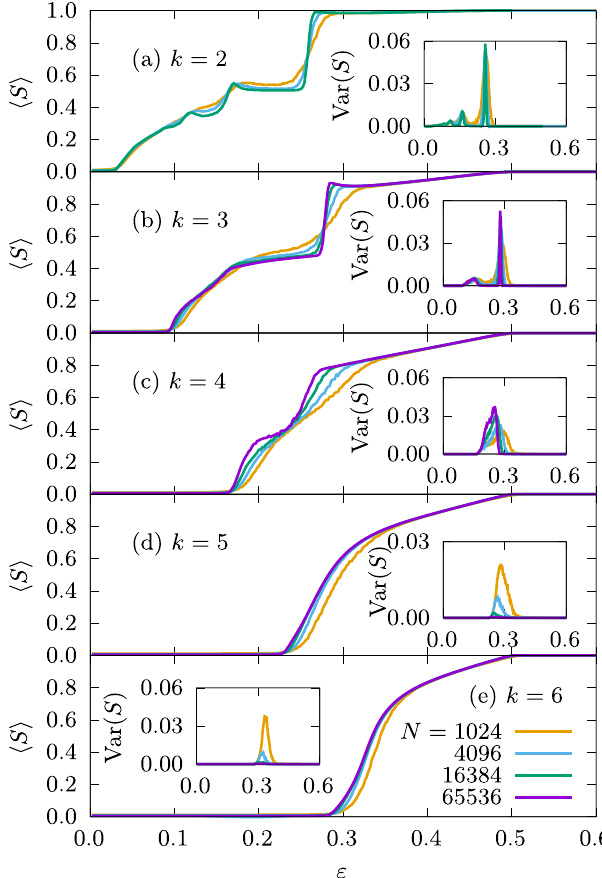
Fig. 2 Behaviour of the mean relative size of the largest cluster, for the Erd ő s – Rényi hypergraph. Mean relative size of the largest cluster h S i as a function of the con fi dence ε for the HOID model on k -uniform ER hypergraphs with edge sizes k = 2 ( a ), k = 3 ( b ), k = 4 ( c ), k = 5 ( d ), k = 6 ( e ), and an expected mean degree of c = 10 for different system sizes ( N ), each. The insets show the variance Var( S ), which is sharpening for k ≤ 3 and vanishing for k ≥ 5, supporting the change from a sharp transition to a crossover.